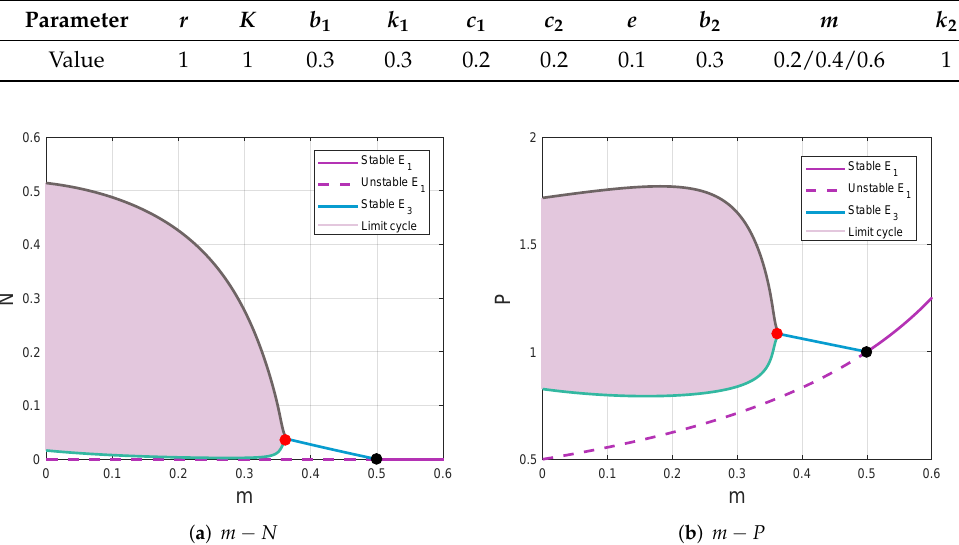
Figure 7. Bifurcation diagram of the system (3) with respect to the predator refuge from cannibalism ( m ) with parameter values as in Table 4: ( a ) N state and ( b ) P